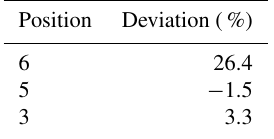
Table 1. Deviations of deformations between FE model and test rig